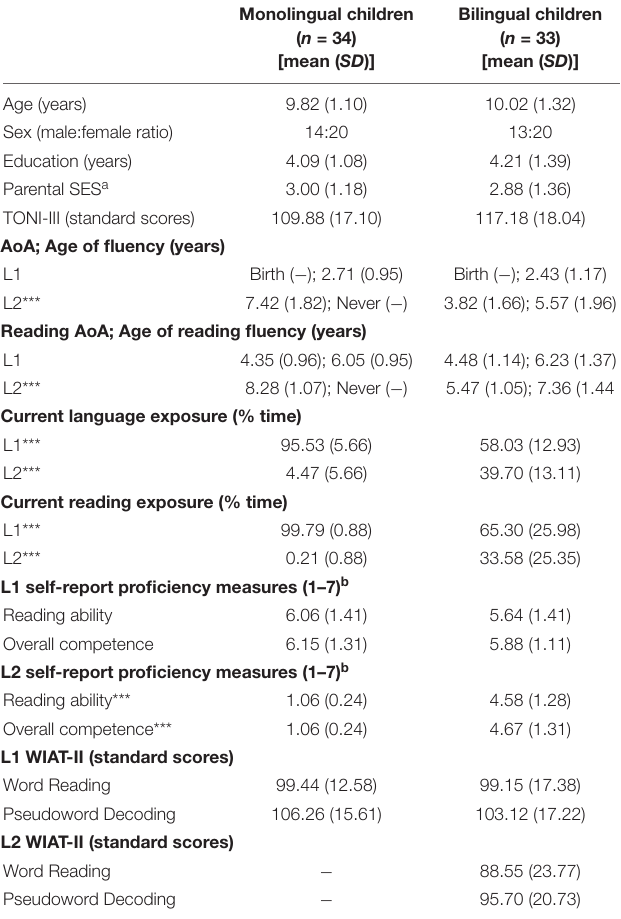
TABLE 1 | Characteristics of the child participant